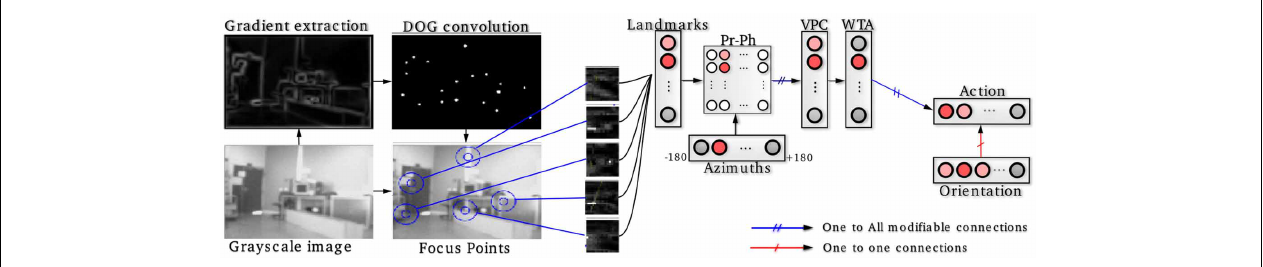
FIGURE 1 | Sensory-motor model of visual place cells (VPCs). Gradient images are convolved with a DoG filter that highlights points of interest on which the system focuses on to extract local views. A VPC learns a specific landmarks-azitmuths pattern. A winner-takes-all